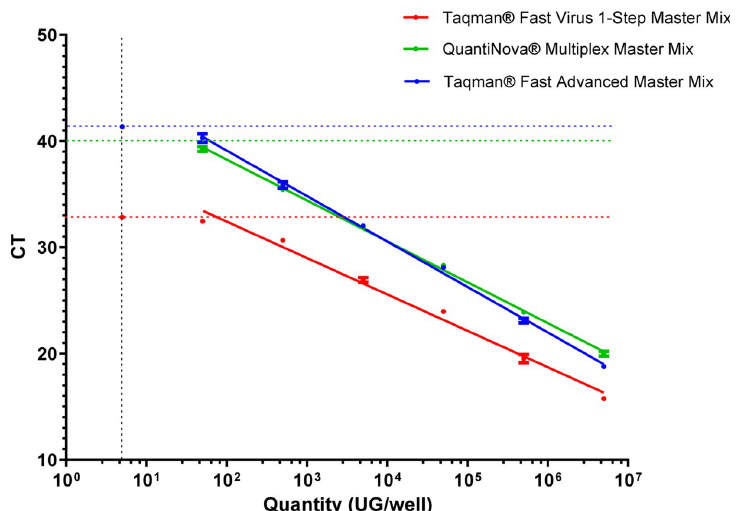
Fig 1. qPCR tests on range of concentrations of the Leptospira 16S plasmid with various enzymatic mixes (Taqman 1 Fast Virus 1-Step Master Mix, QuantiNova 1 Multiplex Master Mix, Taqman 1 Fast Advanced Master Mix). The colored dotted lines correspond to the number of cycles required to obtain the smallest detectable quantity of genome, shown by the black dotted line.